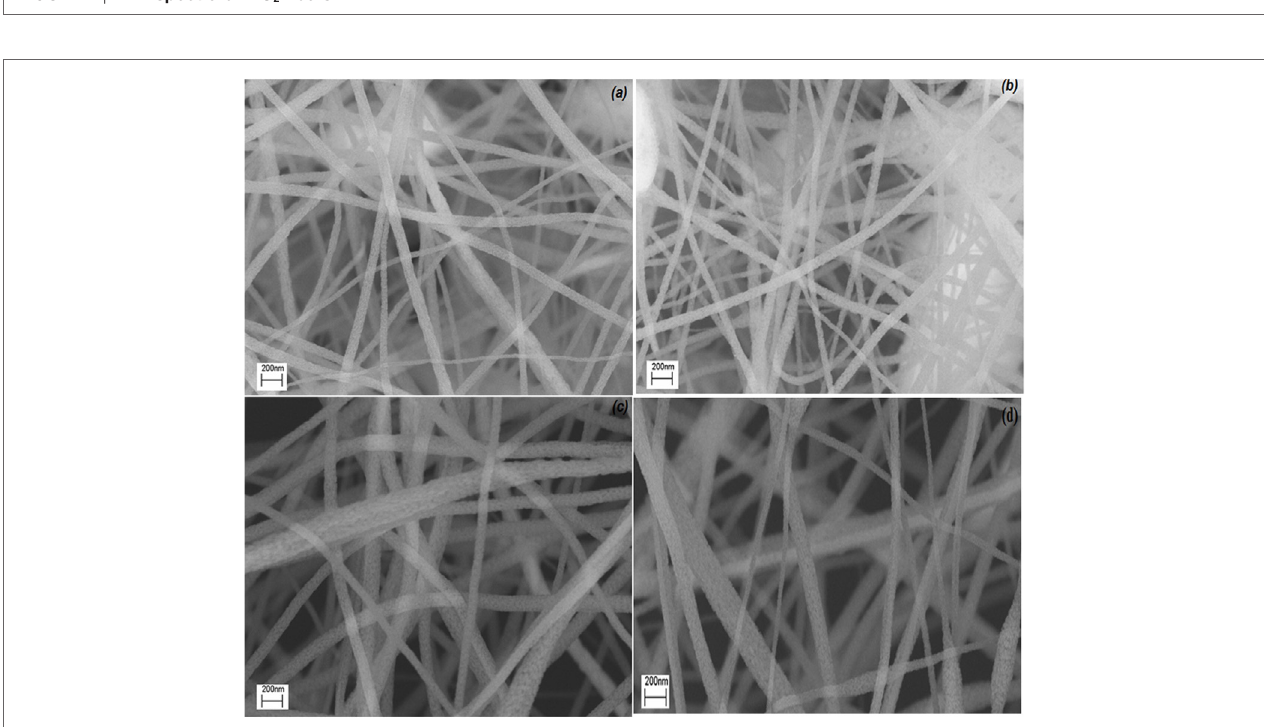
FigUre 4 | FTir spectra of TiO 2 fibers